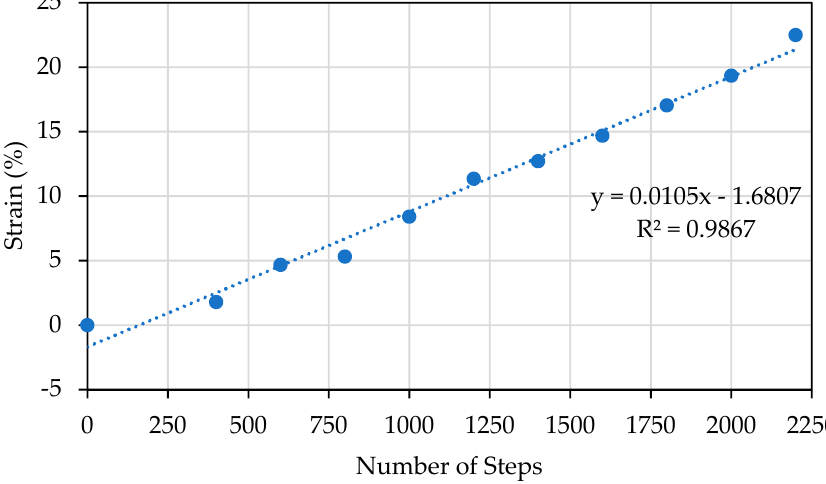
Figure 8. The relation between the number of steps and strain applied to the PDMS.